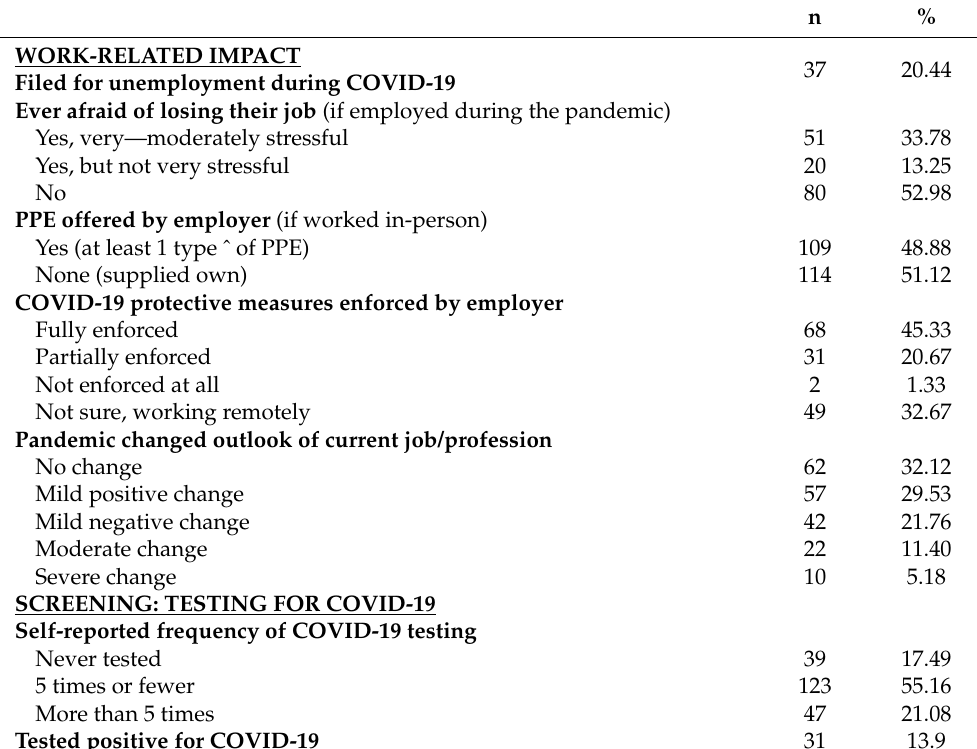
Table 2. Descriptive observations of COVID-19 impact on employment, screening, vaccination, social, health care access, physical health, and mental health.